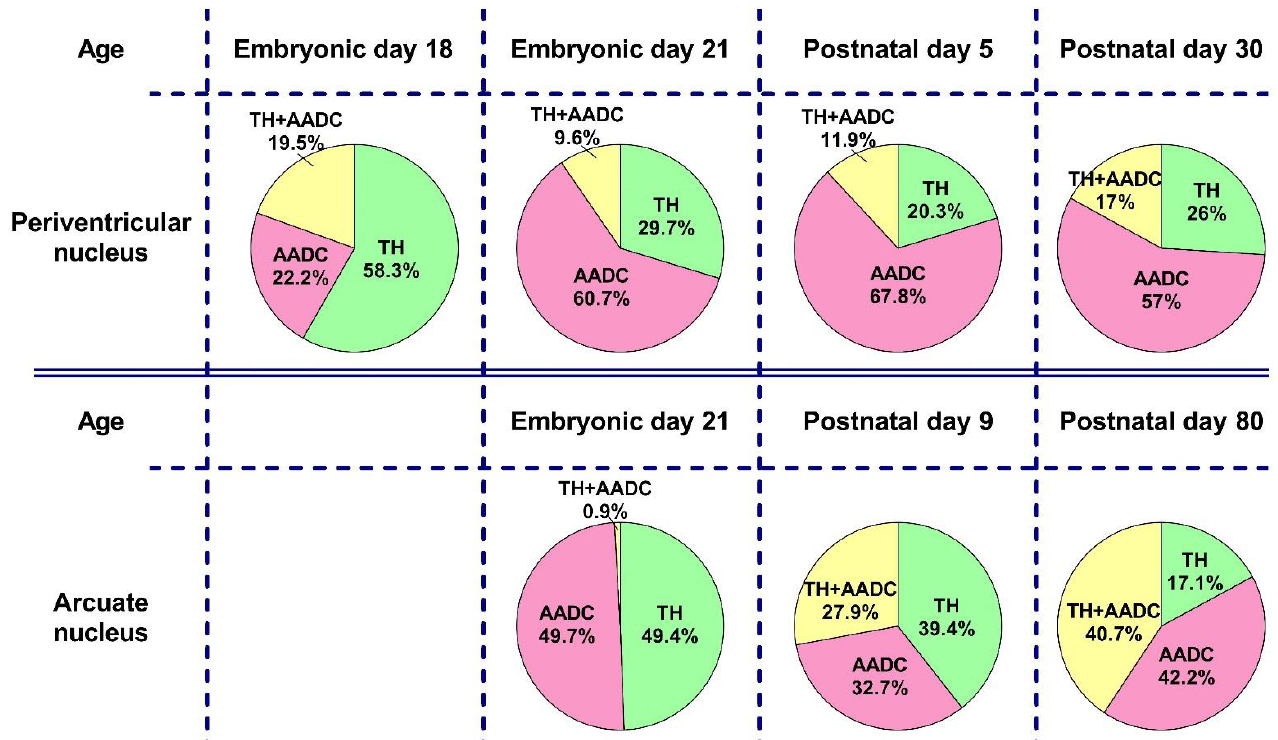
Figure 10. Comparative analysis of the proportion of neurons expressing tyrosine hydroxylase (TH) and aromatic L-amino acid decarboxylase (AADC), as well as bienzymatic neurons (TH + AADC), as a percentage of their total number, taken as 100%, in the periventricular and arcuate nuclei on embryonic days 18 and 21 and on postnatal days 5, 9, 30 and 80, according to the data obtained in this and our previous studies [11,26].